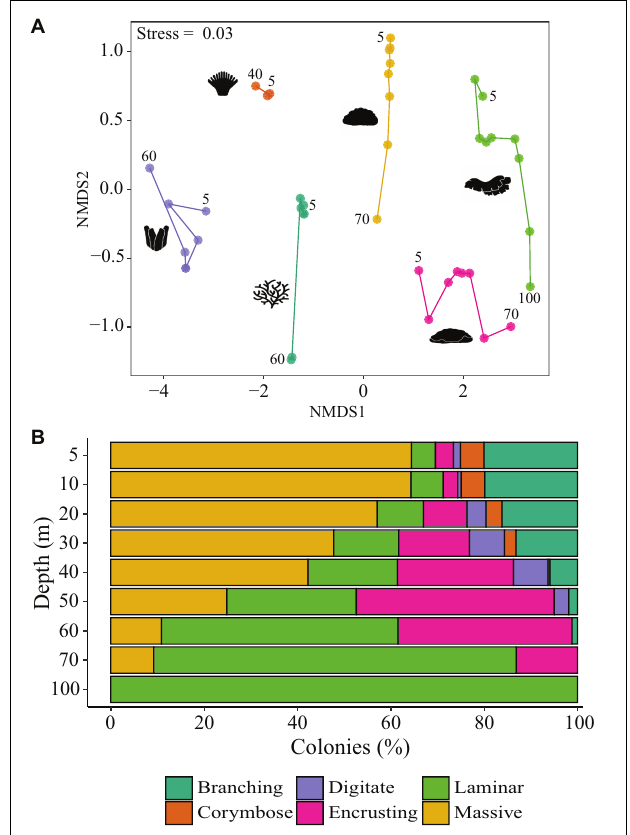
FIGURE 1 | (A) NMDS ordination plot based on Bray-Curtis dissimilarity matrices (2D, stress = 0.03). Each color represents a particular growth form category and each dot the assemblage composition at genus-level for a given depth and morphological category (pooled by sites). Dots are connected by consecutive depths (m), and numbers on the edges of each line denote the shallowest and deepest depths for a given morphological category; (B) Total cumulative percentage of the relative abundance of the six growth form categories (branching, corymbose, digitate, encrusting, and laminar, massive) along a depth gradient ranging from 5 to 100